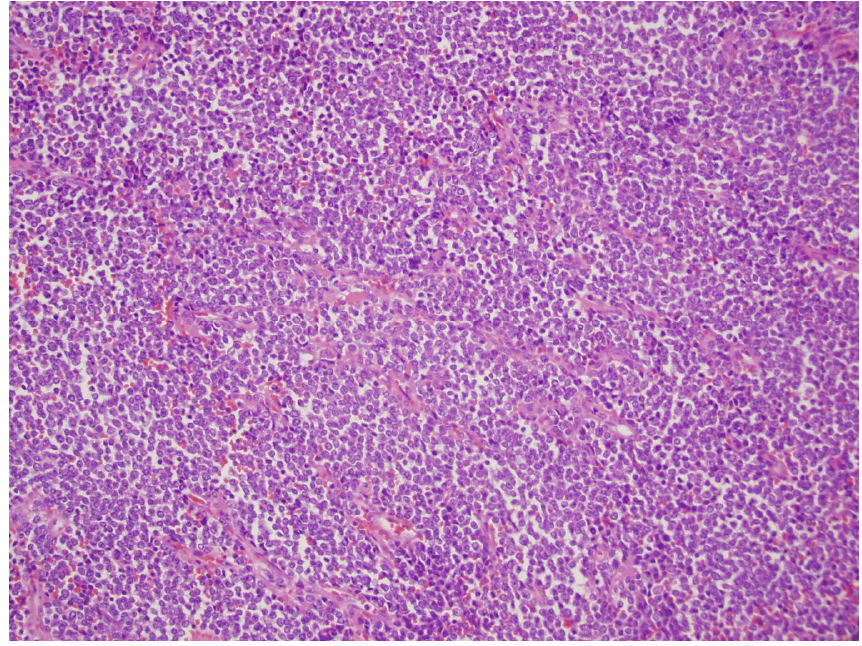
FIGURE 3. Low power view of tumor. Rosettes are not demonstrated in this specimen.